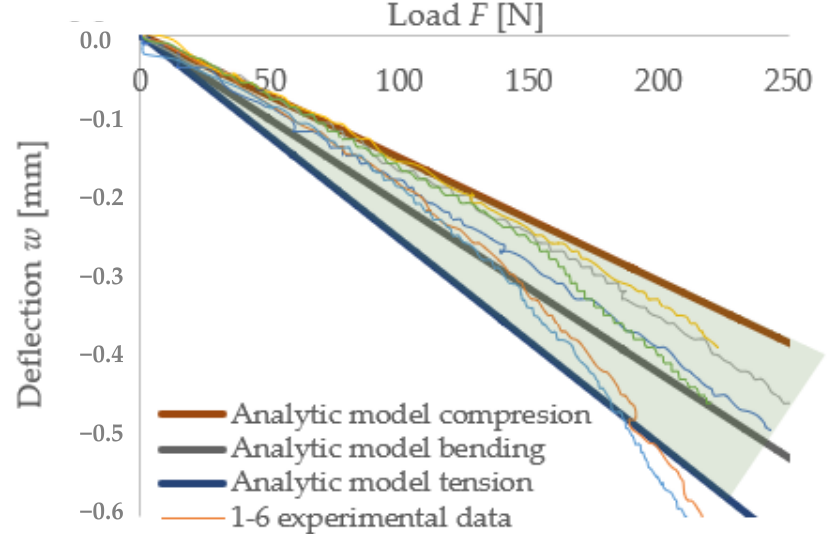
Figure 20. Comparison of experimental and analytical results.